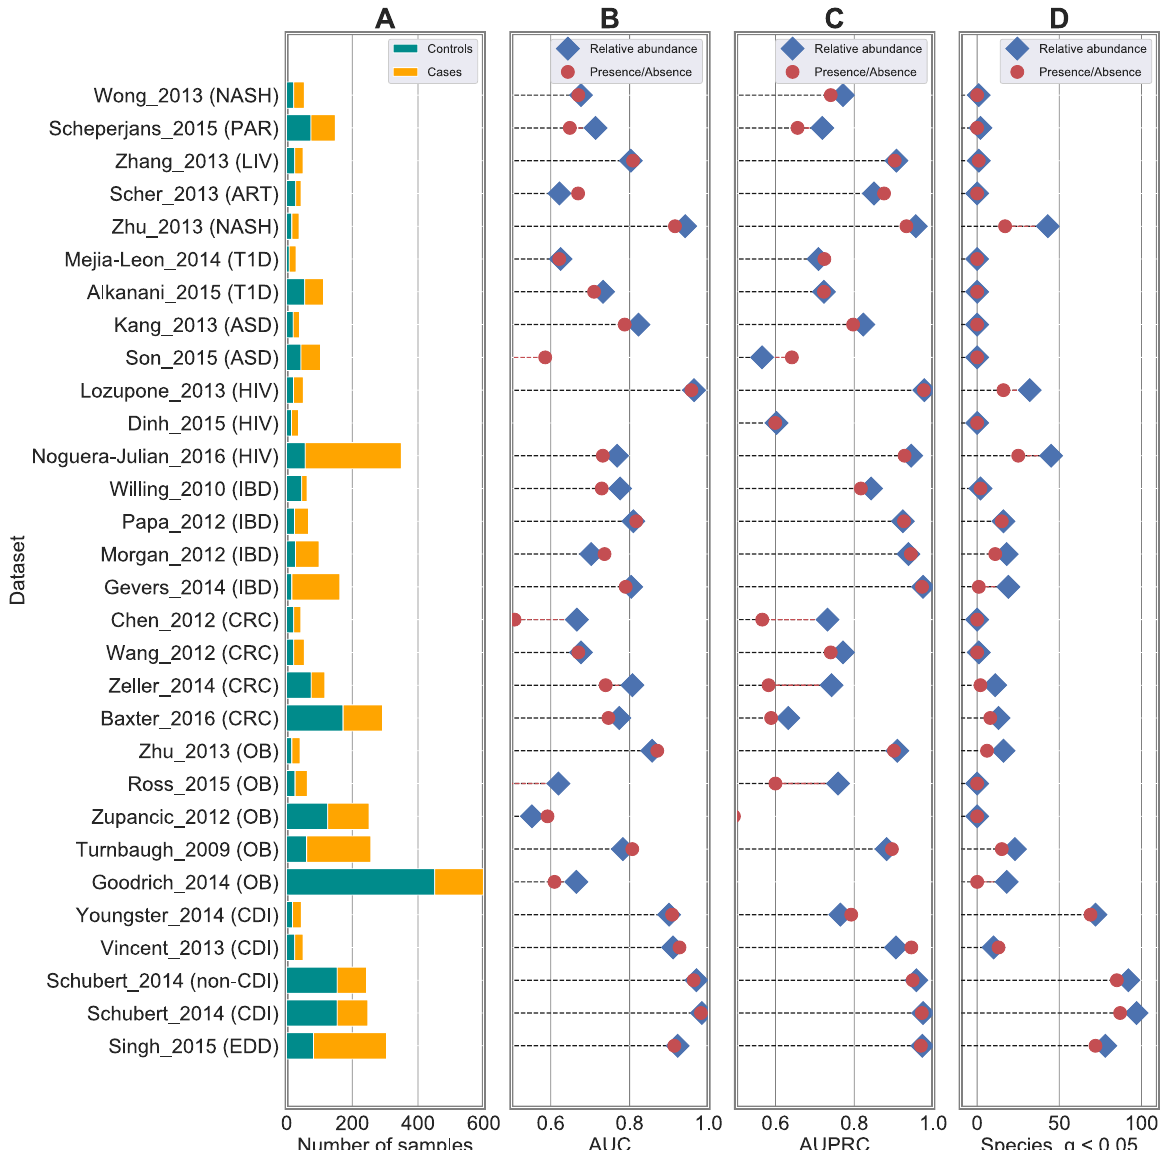
Fig 2. Classification accuracies are robust to degradation from genus-level relative abundance to presence/absence profiles in 16S rRNA datasets. Results obtained on 30 case-control studies for host phenotype classification from human microbiomes. ( A ) Number of case and control samples across the different studies. ( B ) AUC and ( C ) AUPRC scores using RF as back-end classifiers on species-level taxonomic profiles. Comparison between relative abundance (in blue) and presence/absence (in red) profiles highlighted negligible differences and no statistical differences in none of the studies (see S5 Table for p-values) as found also in shotgun datasets (see Fig 1 ). Metrics of comparison in terms of AUC, AUPRC, precision, recall, and F1 are summarized in S5 Table . ( C ) Number of statistically significant taxa from relative abundance (in blue) and presence/absence (in red)